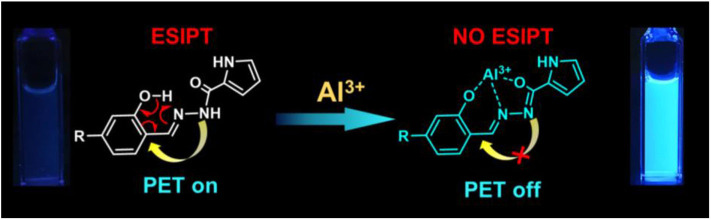
Proposed sensing mechanism of sensors to Al3+.